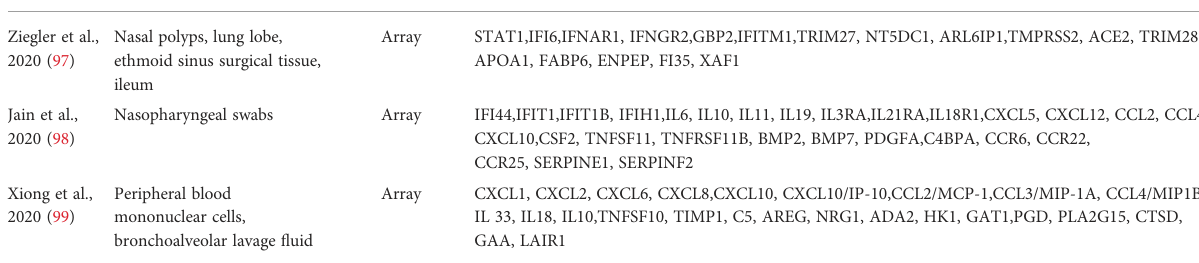
TABLE 2 SARS-CoV-2 – associated genes in the relevant reference. Reference Tissue ( Homo sapien s)